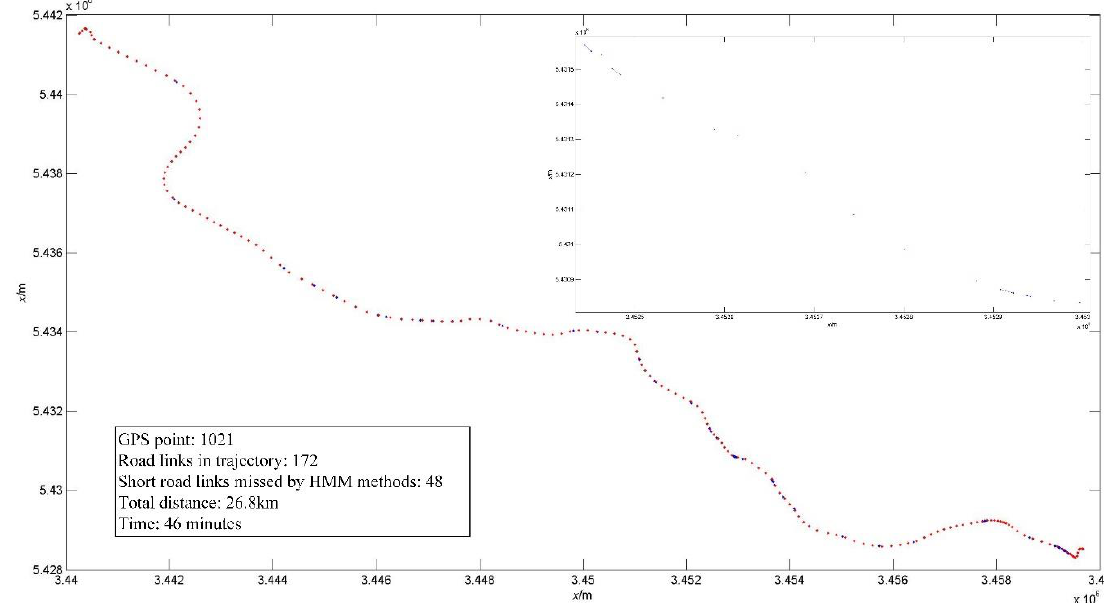
Figure 8. The improved results from Viterbi